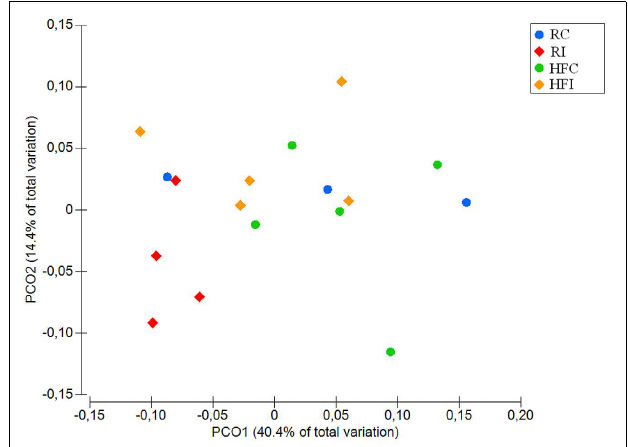
FIGURE 7 | Principal coordinates analysis (PCoA) of weighted UniFrac distances of samples from sacculus rotundus. Significant p -value = 0.048 for Infected vs. non-infected comparison was obtained from